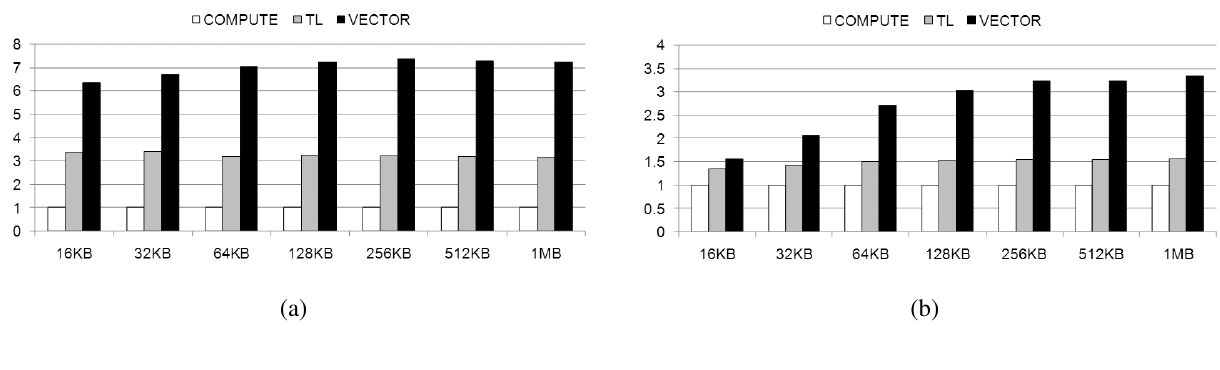
Figure 12. Speed-up of decoding time compared with COMPUTE on 128 × 128 coefficient matrix size; ( a ) PPE; ( b ) SPE.